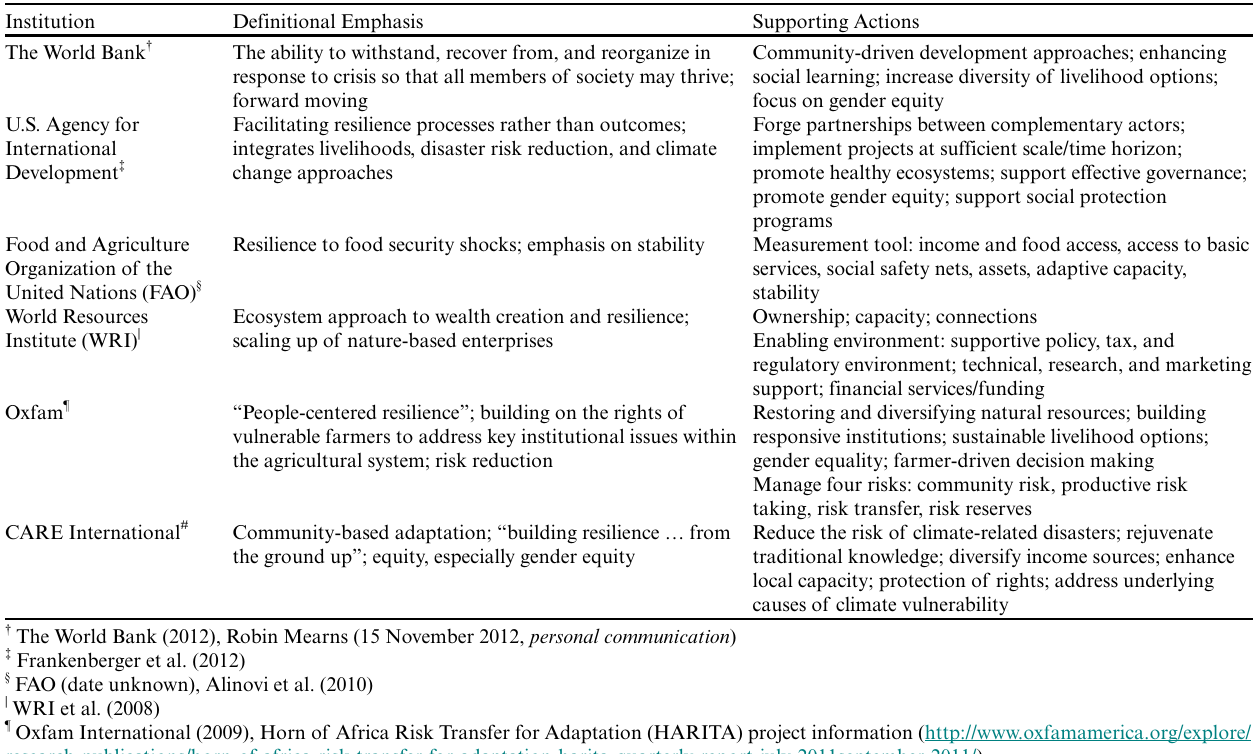
Table 1 . Approaches to resilience among select development